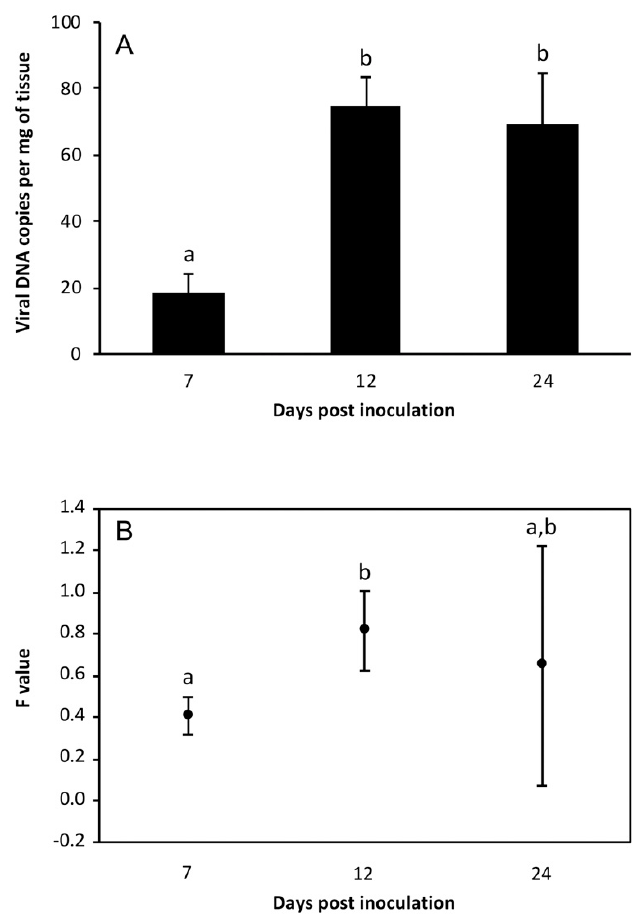
Figure 3. Viral loads ( A ) and relative mcp gene expression values ( B ) in gilthead seabream fingerlings orally challenged with LCDV-positive Artemia metanauplii (mean ± standard deviation; n = 7). Different letters indicate significant differences ( p < 0.01) (Mann–Whitney U-test, Holm–Bonferroni correction).